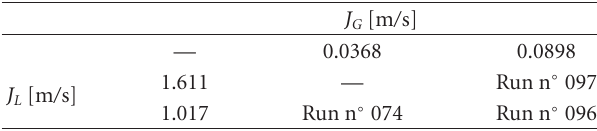
Table 1: Water and gas superficial velocities J L and J G of the tests investigated in this